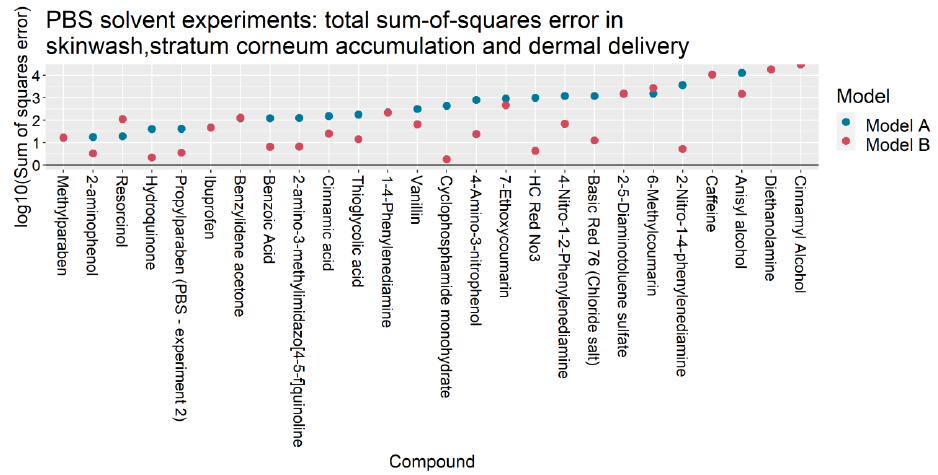
Figure 2. Total sum-of-squares errors 𝐸 𝑇𝑜𝑡𝑎𝑙2 (as defined in Table A4) of Models A and B for IVPTs conducted using PBS solvents.